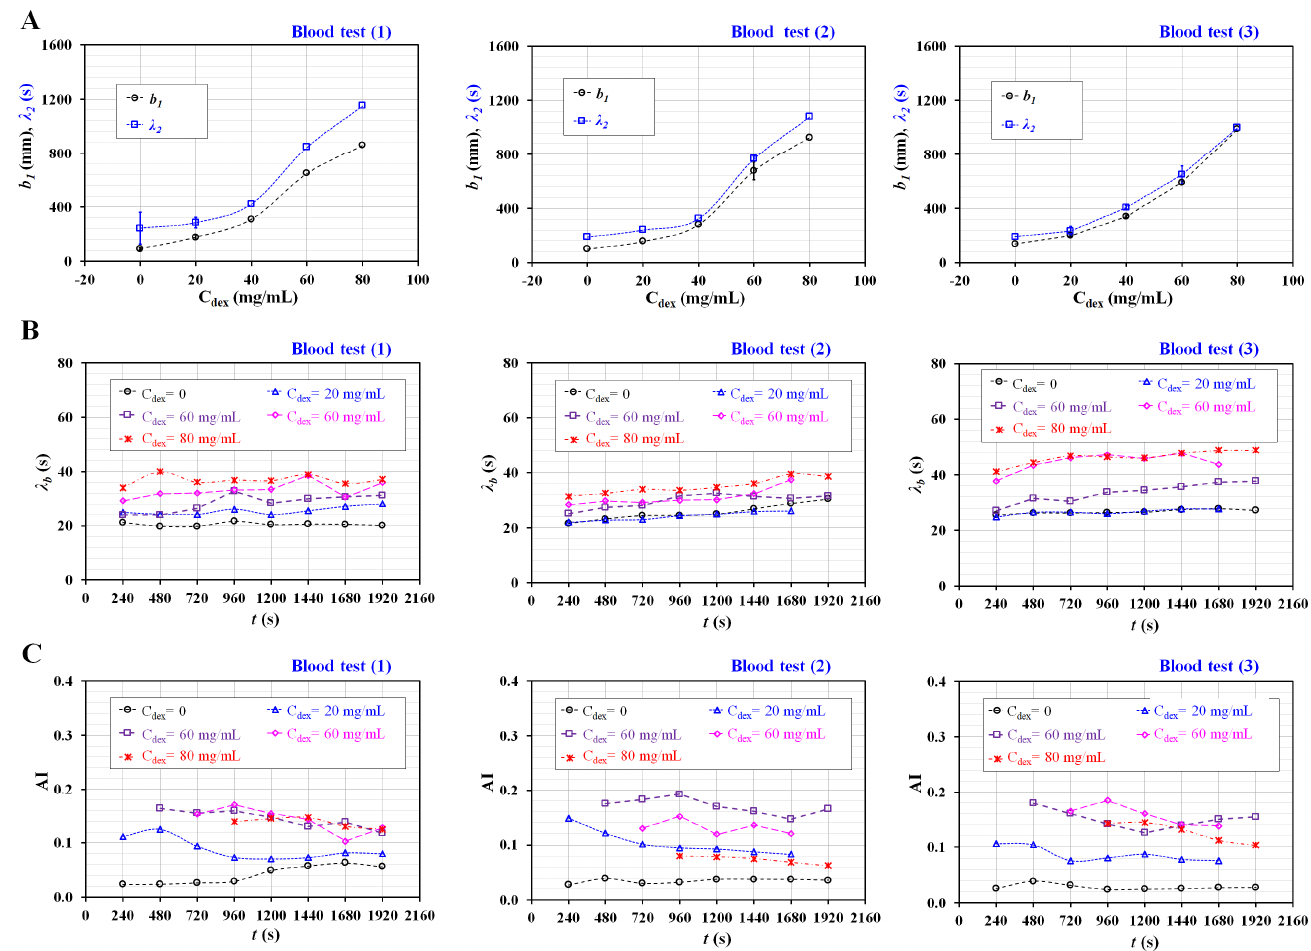
Figure 6. Quantification of three rheological properties for RBC aggregation-enhanced blood. Blood (Hct = 50%) was prepared by adding normal RBCs into a specific concentration of dextran solution (C dex ) (C dex = 20, 40, 60, and 80 mg/mL). Three kinds of blood test ( n = 3) were conducted to guarantee repeatability of the present method. ( A ) Variations of b 1 and λ 2 obtained by regression analysis of β with respect to C dex . ( B ) Temporal variations of λ b with respect to C dex . ( C ) Temporal variations of AI with respect to C dex .